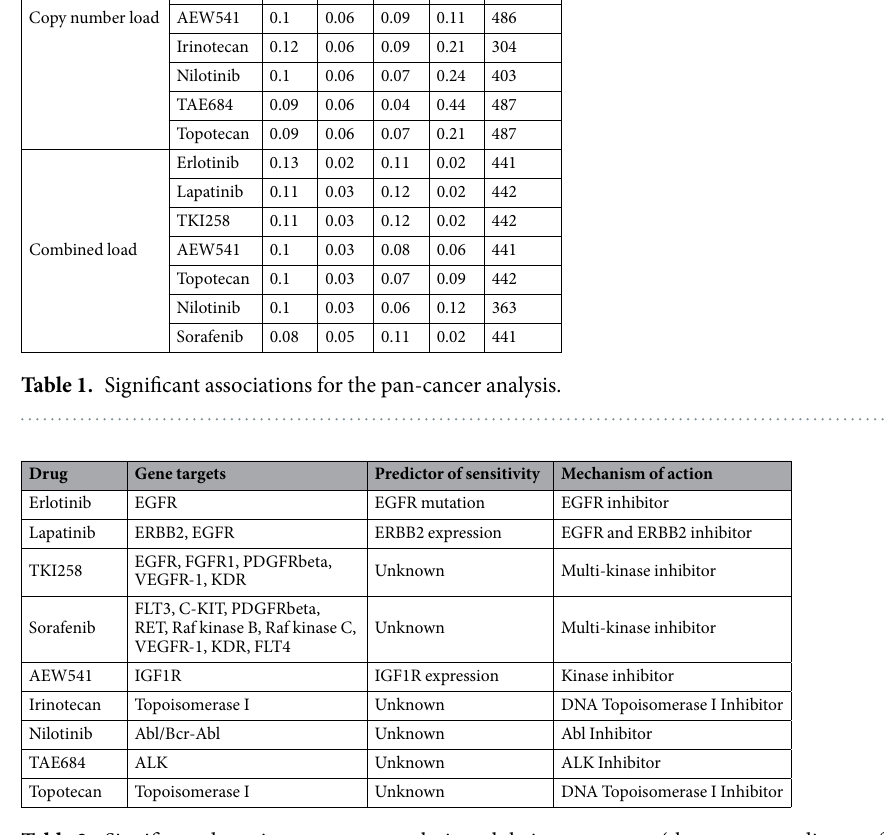
such as specific mutations or expression patterns determine sensitivity to a given drug, the association between genetic load and drug response should not be particularly strong and care must be taken to control for hetero- geneities in the data. Indeed, when we tested for an association between genetic load and drug response across all drugs and all cancer types we found no significant relationship for point mutation load ( ρ = 0.01, p = 0.17 Spearman; r = 0.003, p = 0.4 Pearson) and only a weak relationship for copy number changes ( ρ = 0.03, p = 0.002